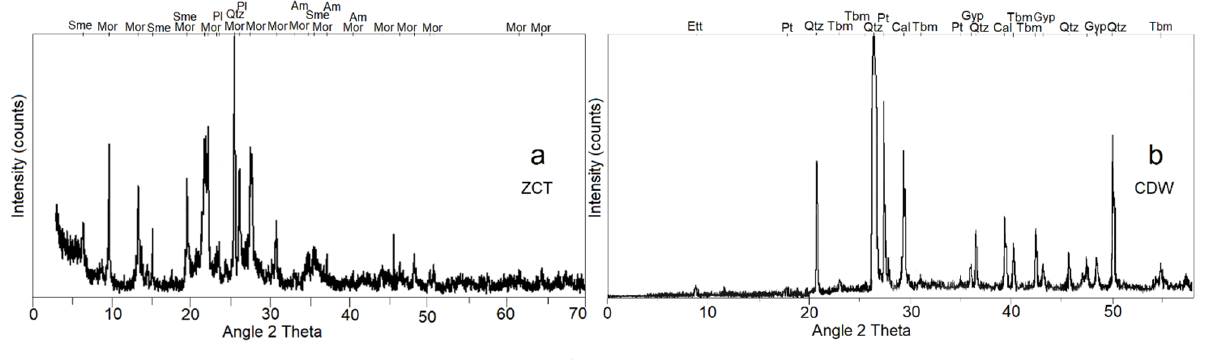
Figure 1. X ‐ ray diffraction patterns of researched samples: ( a ) sample ZCT, ( b ) sample CDW. Figure 1. X-ray diffraction patterns of researched samples: ( a ) sample ZCT, ( b ) sample